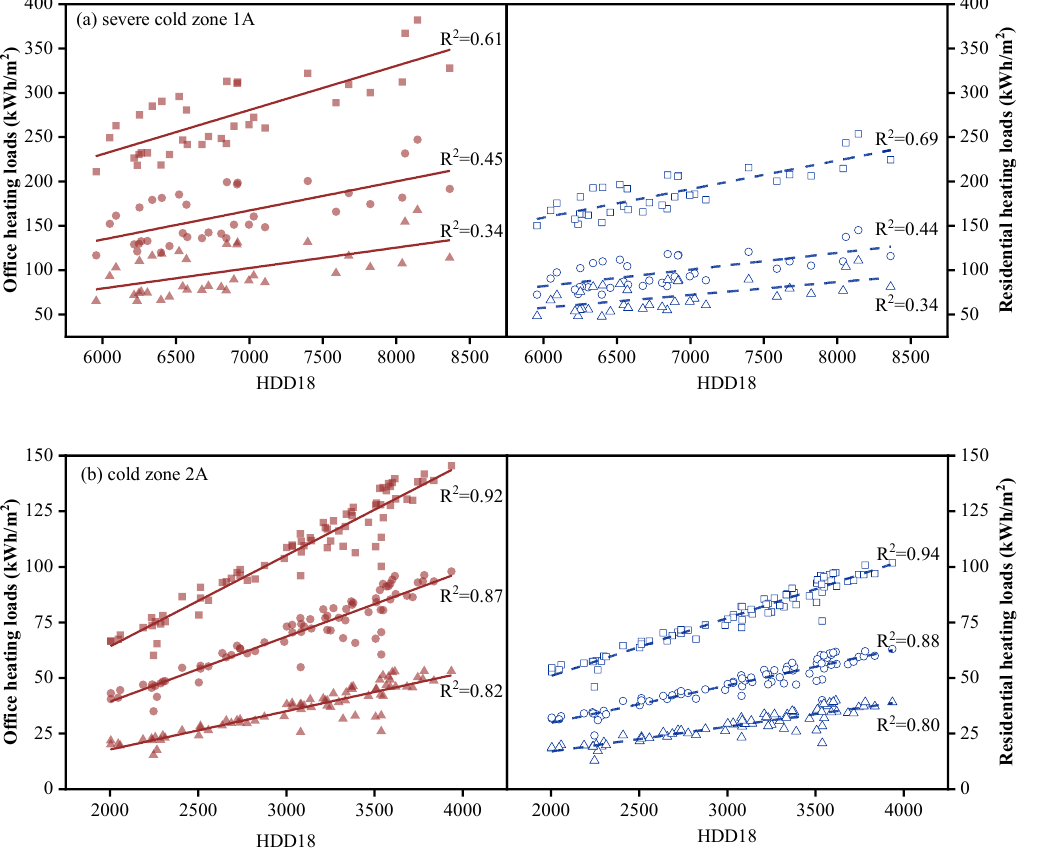
Figure 12. Annual heating loads vs. HDD18 in different climate zones: ( a ) severe cold zone 1A; ( b ) cold zone 2A; and ( c ) hot summer and cold winter zone 3A. 5. Conclusions In this study, we calculated the monthly heating balance point temperature of the building based on the quasi-steady-state method provided by ISO 52016 and determined it as the base temperature to predict building heating energy demand using the variable- base degree-day method. Based on the above calculation procedure, a building perfor- mance evaluation tool BPT V1.0 was developed, which provides a quick estimation of the